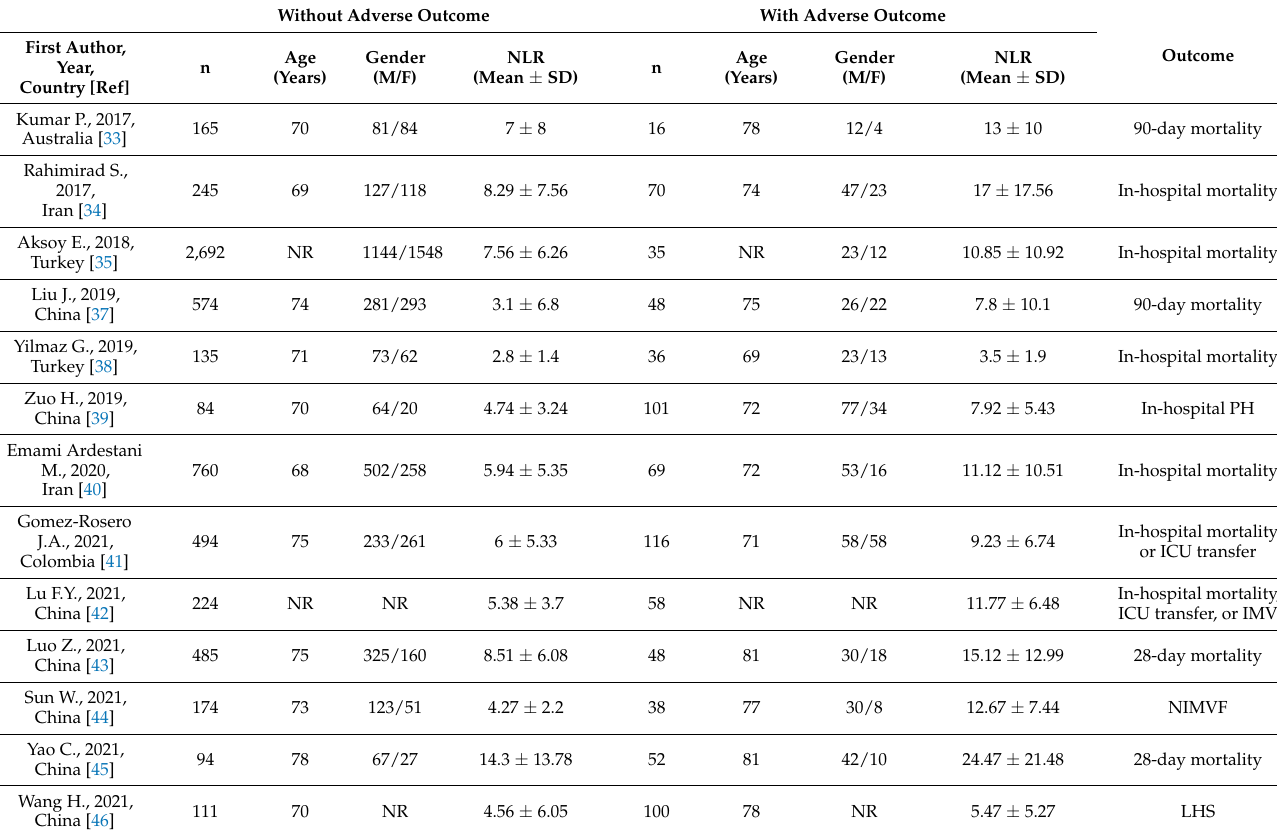
Table 3. Characteristics of studies reporting absolute neutrophil-to-lymphocyte values in AECOPD with and without adverse outcomes. Without Adverse Outcome With Adverse